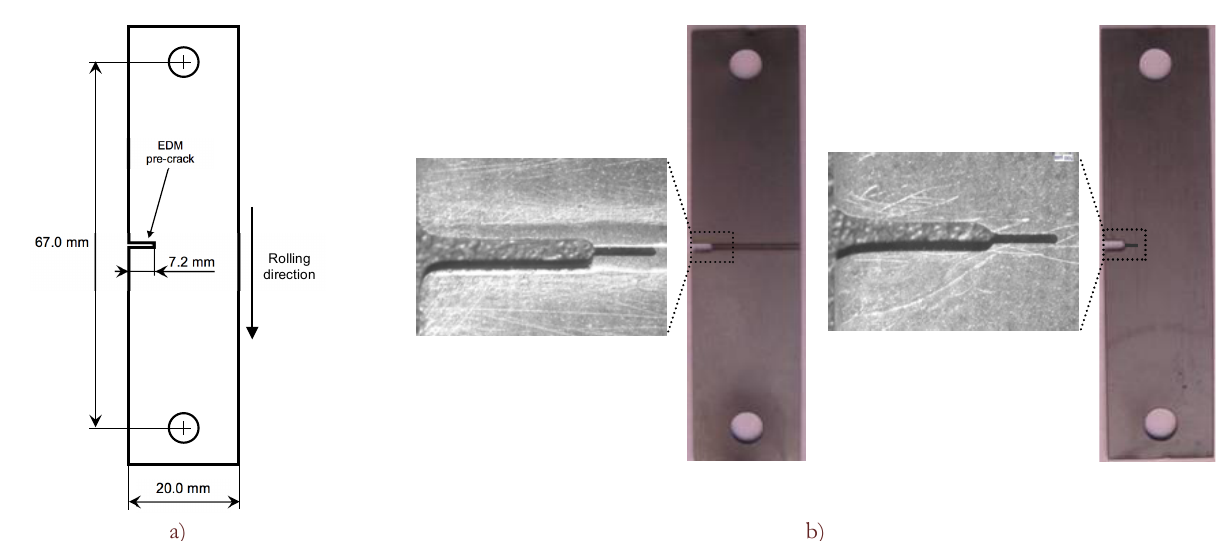
Figure 8: SEC specimens for fracture tests: a) specimen geometry and b) reference and welded specimens with highlights of the pre- cracks [7].